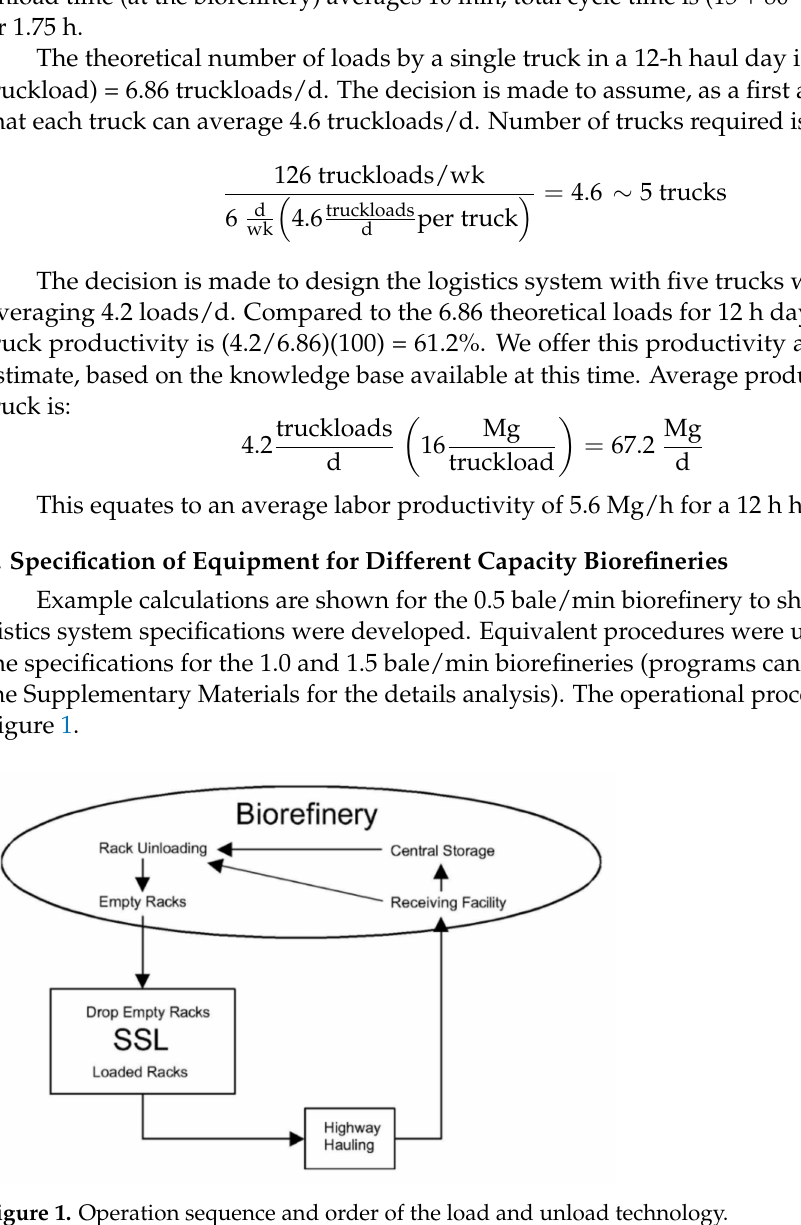
Figure 1. Operation sequence and order of the load and unload